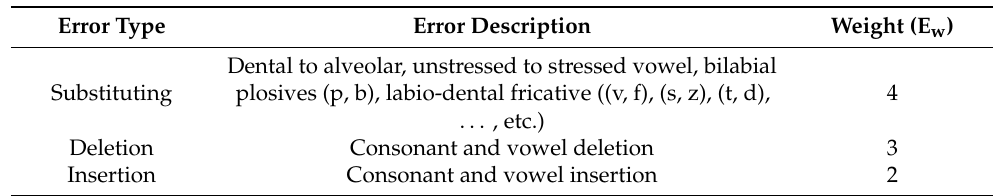
Table 2. Phonological